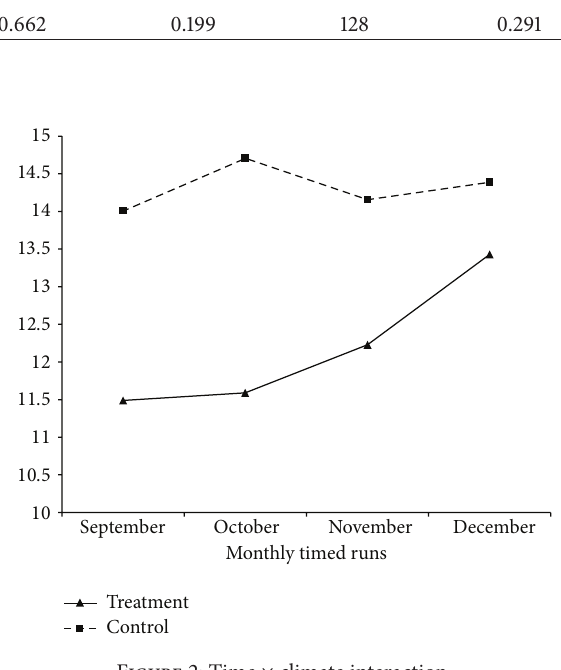
Figure 2: Time × climate